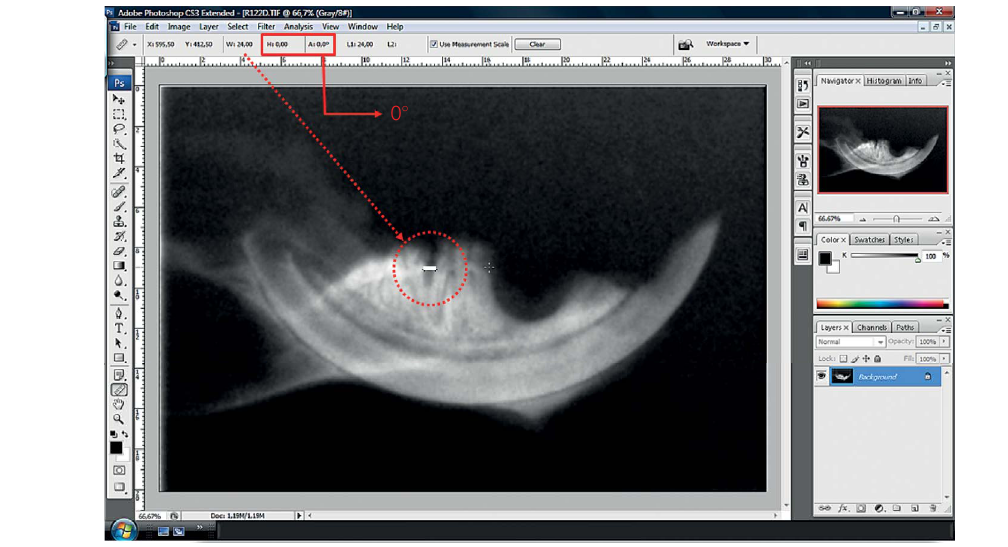
Figure 2. Rate of tooth movement is represented by the interdental distance between the cementoenamel junctions of right mandibular first and second molars (dotted arrow), which is indicated by the width value (W) and zero degrees of angulation (A) and height (H). The values of the horizontal (x) and vertical (y) axes of the image are 595.50 pixels (30 mm) and 412.50 pixels (20 mm),